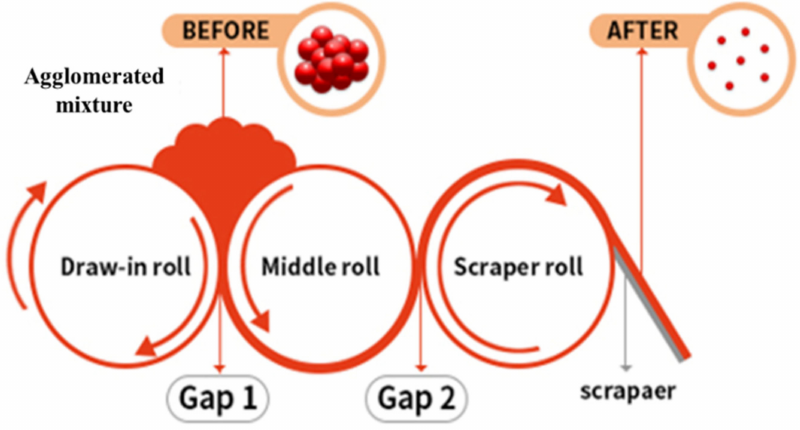
Figure 2. Three-roll milling of agglomerated mixture for refinement and uniformly